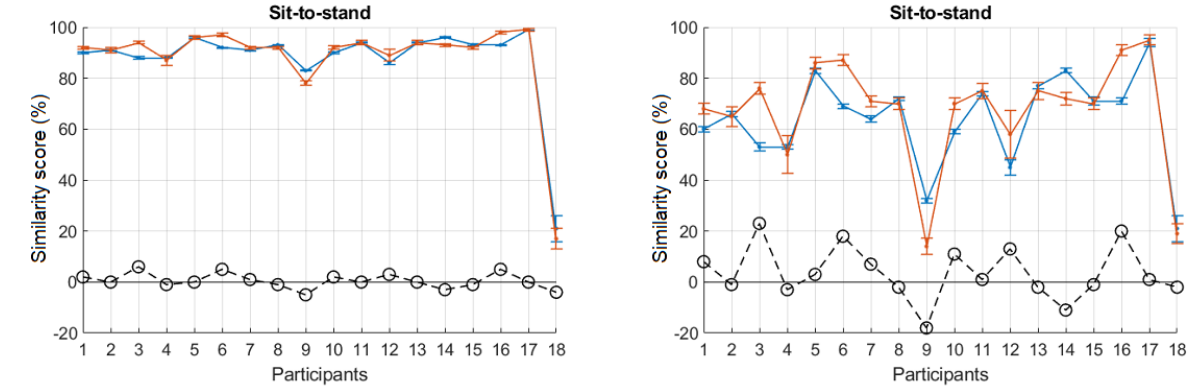
Figure 10. Effect of altering limits (Du and Ll, obtained from the worst performance) on the scores: multiplied by 2 (left) and divided by 2 (right). Error bars indicate standard error.